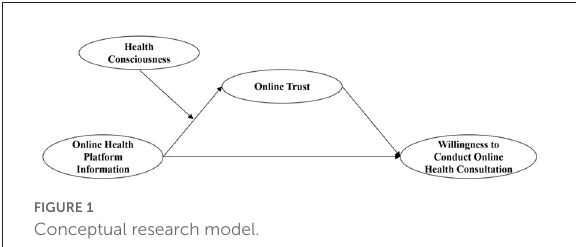
FIGURE1 Conceptual research